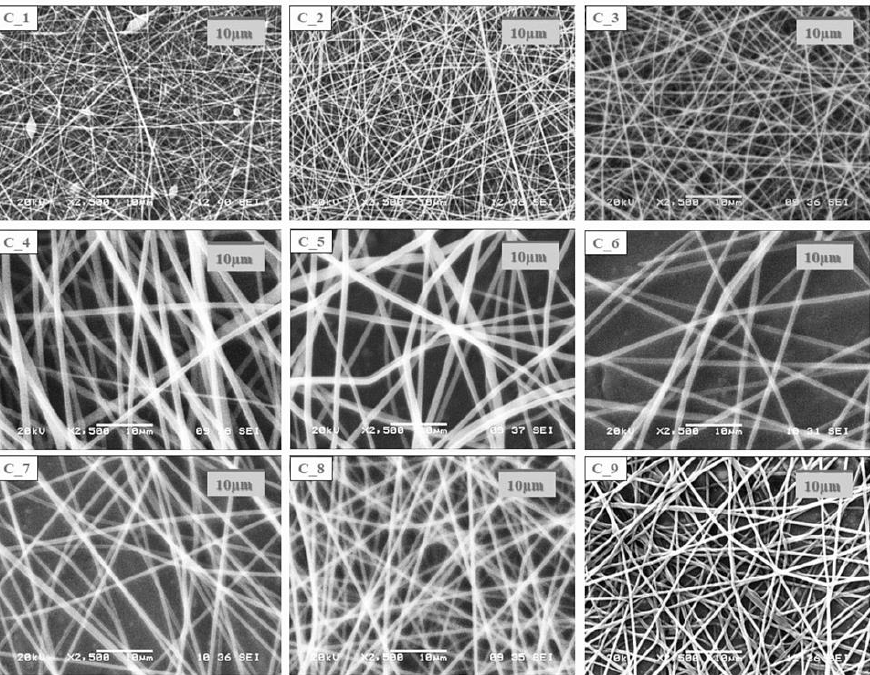
Figure 1. SEM images of electrospun samples prepared from different composition core precursor solutions (magnification: 2500×).